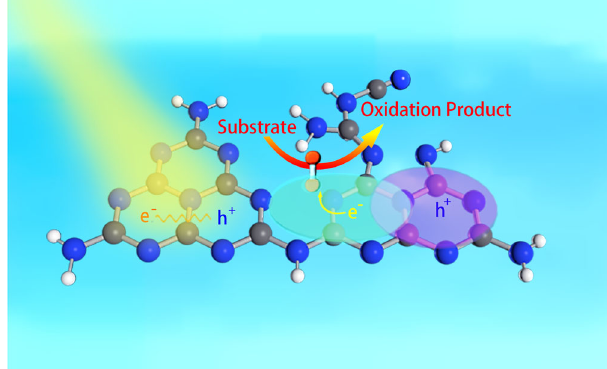
Fig. 4 Roles of each molecular constituent in carbon nitrides. Scheme of the light harvesting and the spatial distribution of electron/hole on M1 – M2 framework with the electron coupling of O 2